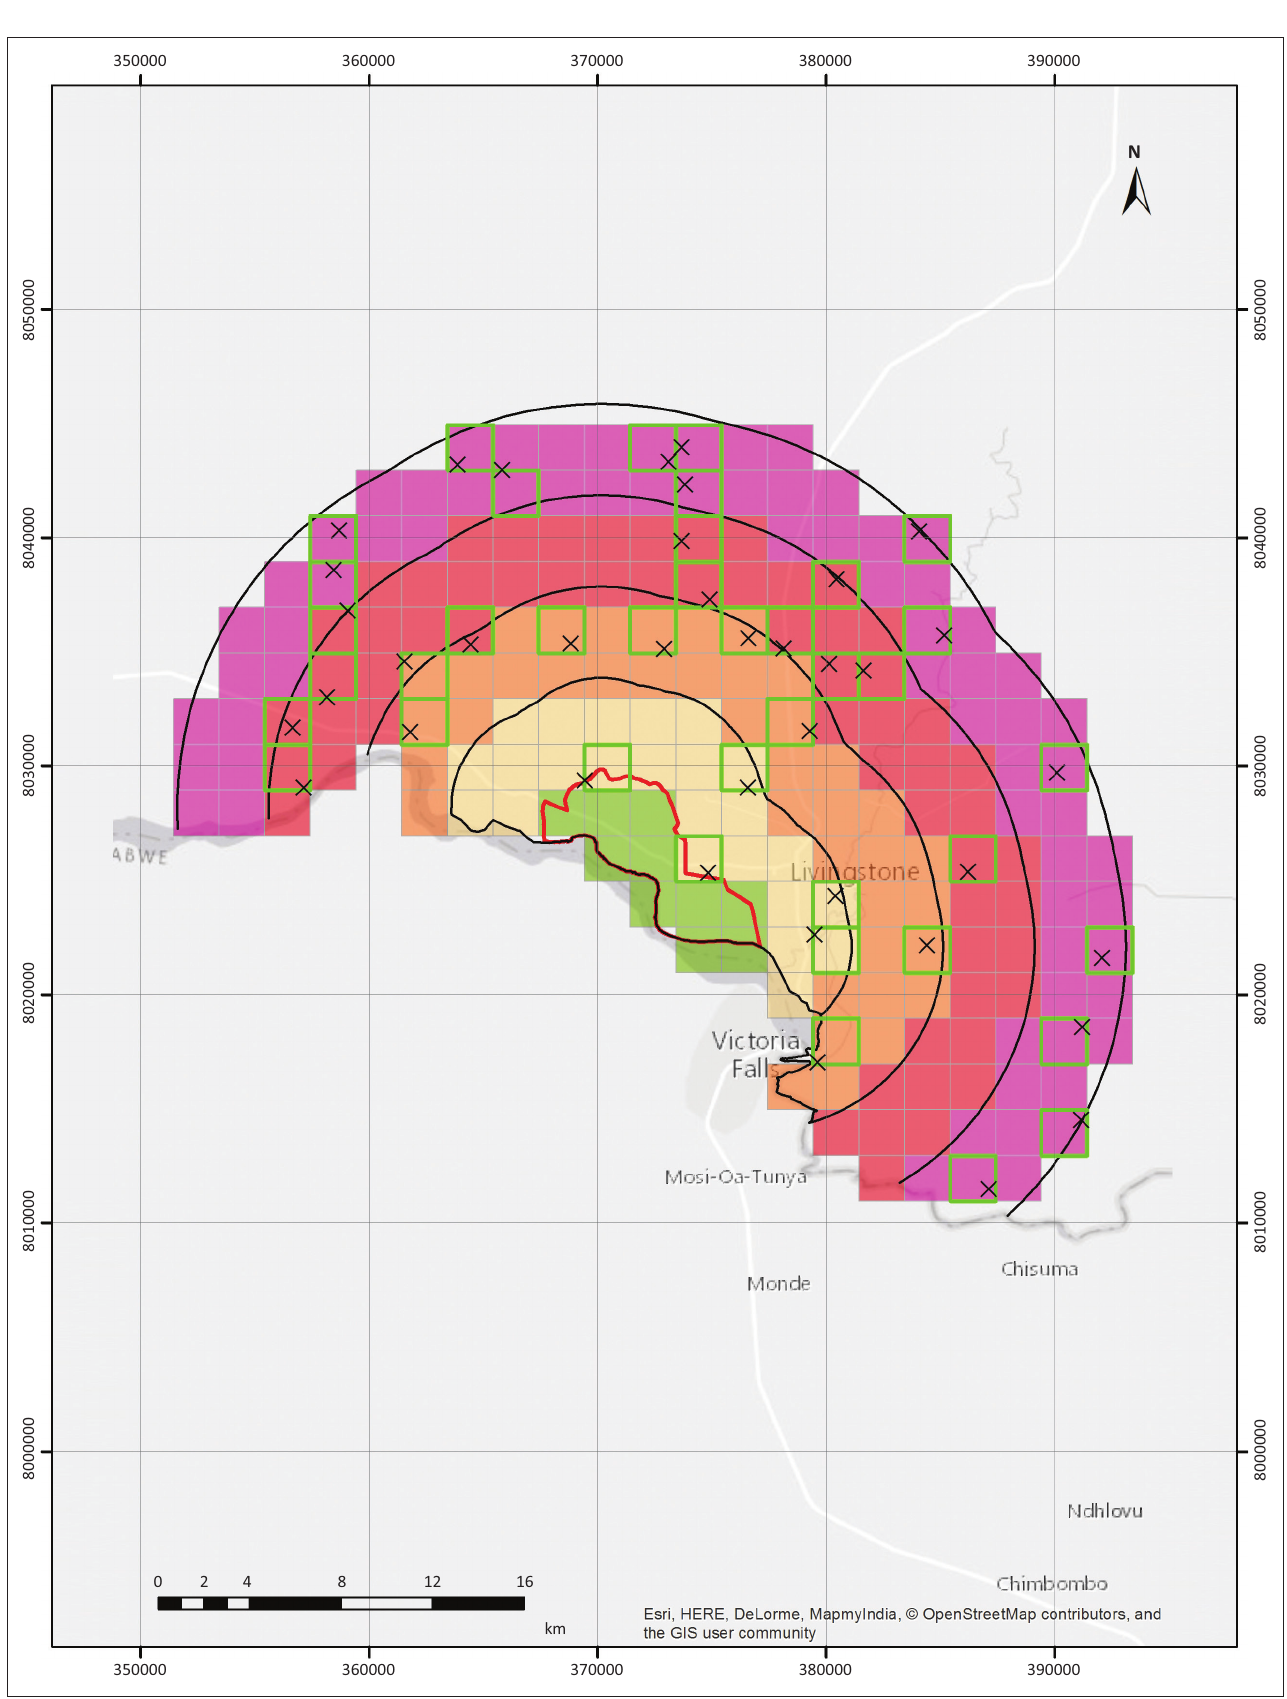
FIGURE 1: Map of the Livingstone area showing the boundary (red line) of the OZP (green shaded area), the distance bands at 4-km intervals from the boundary of the OZP (black lines) and the 2 km × 2 km grid (with block colours indicating into which distance and the block falls). Sampled blocks are highlighted (green outline), with the location of survey start points in sampled blocks shown (black